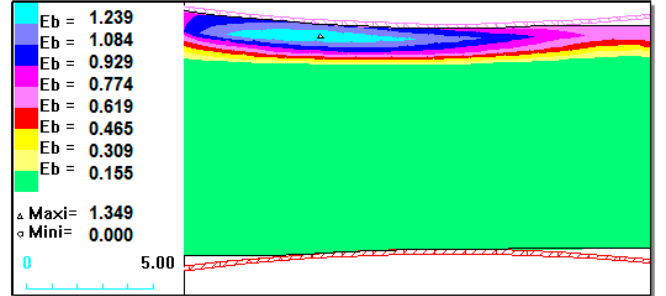
Figure 5. State of strain intensity for the Ni–5%Al alloy coating for 5% relative draft with different coating thicknesses at the upper part rolling band h p = 1.2 mm.